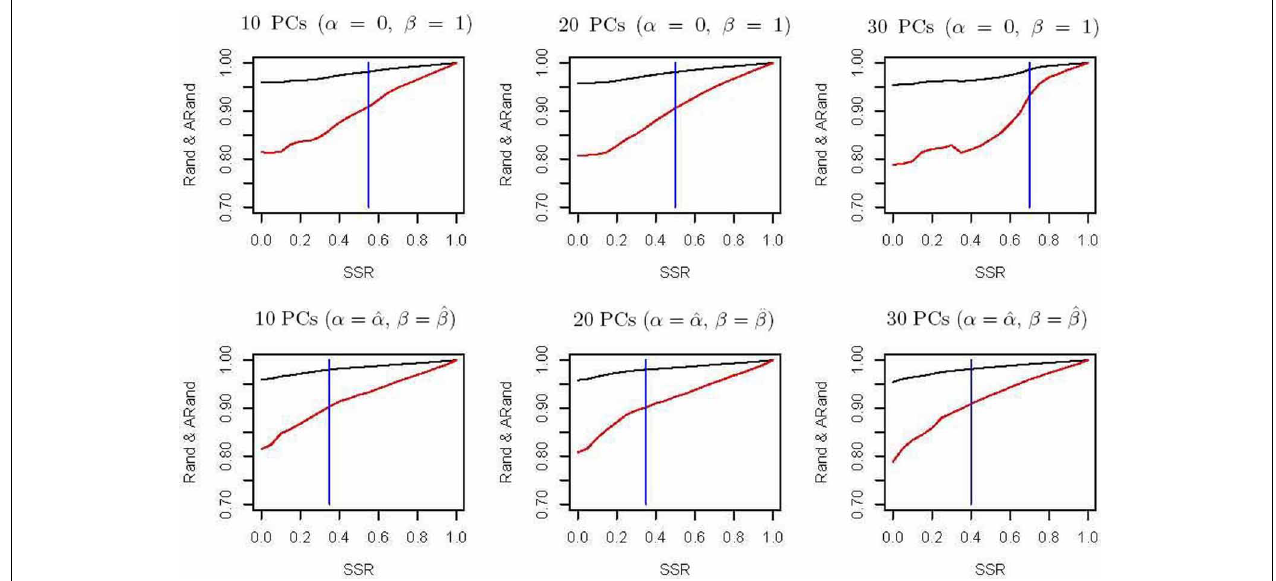
FIGURE 2 | Rand indices (black) and adjusted Rand indices (red) between the true subgroups and the clustering results with various numbers of the top PCs. A vertical blue line indicates the point of SSR , at which the Rand index and adjusted Rand index are both larger than 0.90 for the first time.